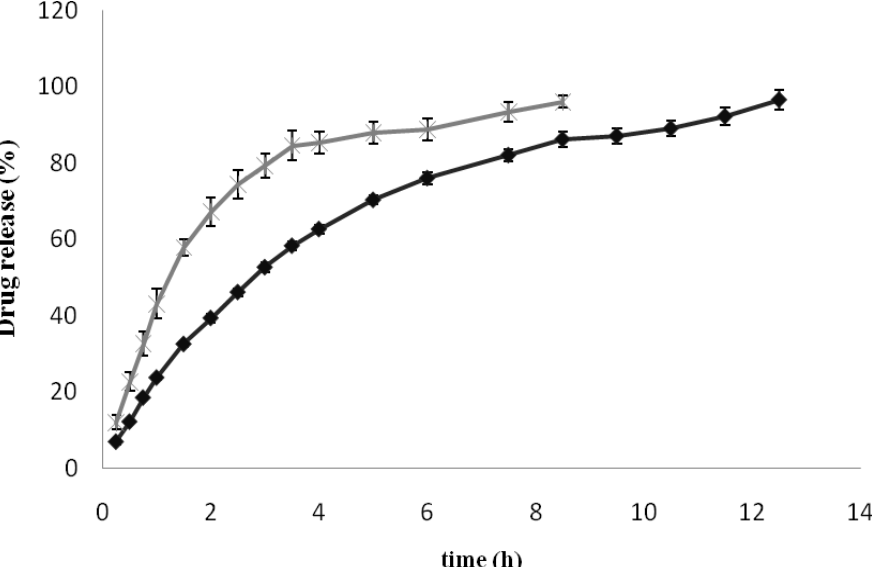
solution (×) (means ± SD, n =